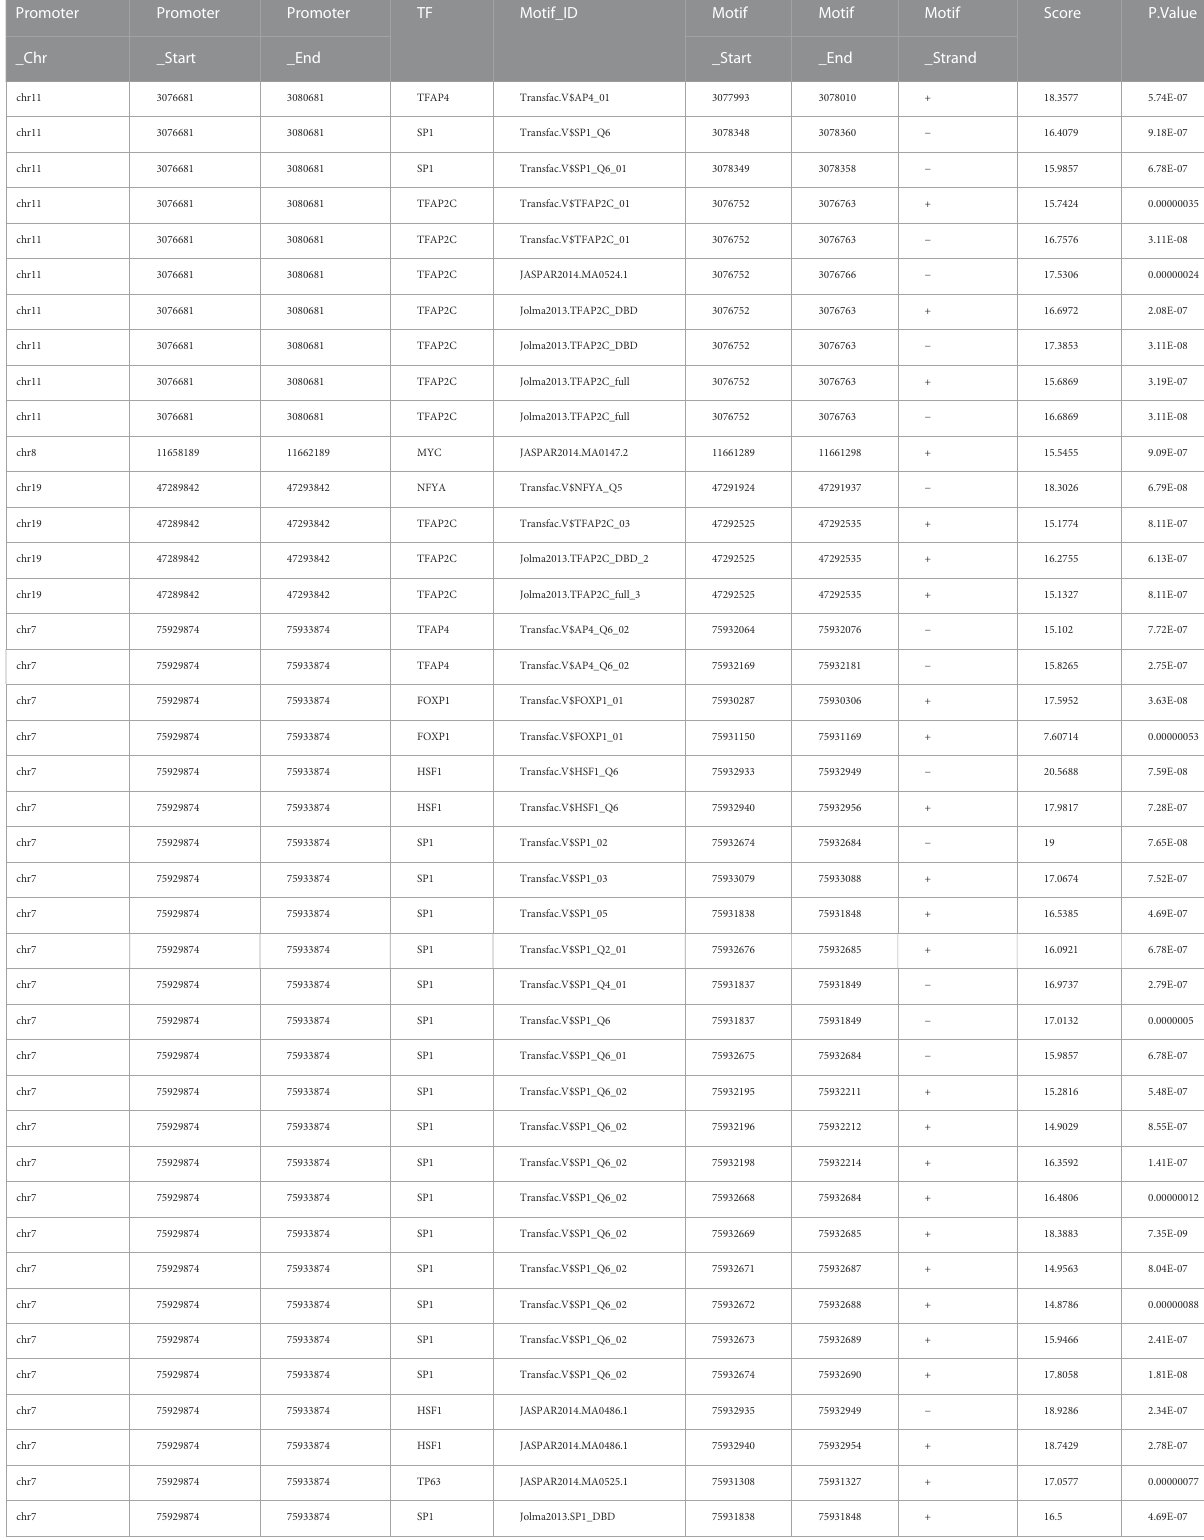
TABLE 3 Regulation of FGRs expression by transcription factors identi fi ed using Chip-Seq